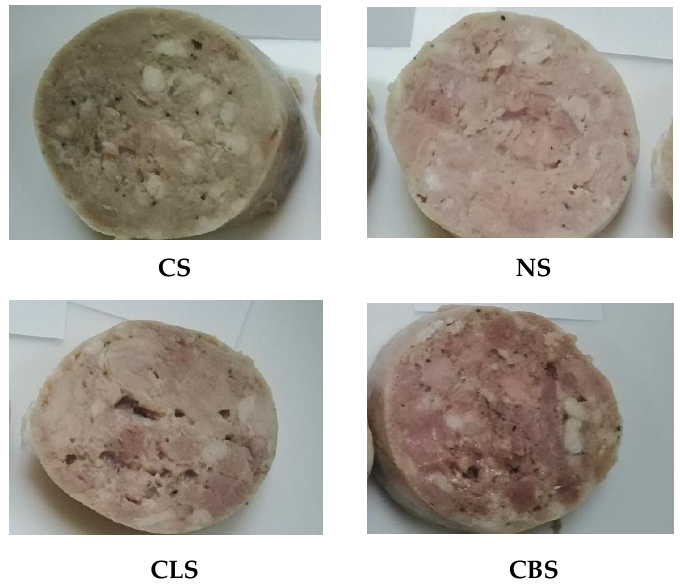
Figure 2. Sausages after 3 days of storage: CS, sausages with salt; NS, sausages with curing salt (containing nitrates); CLS, sausages with Cistus incanus extract and lycopene; CBS, sausages with Cistus incanus extract and betanin.